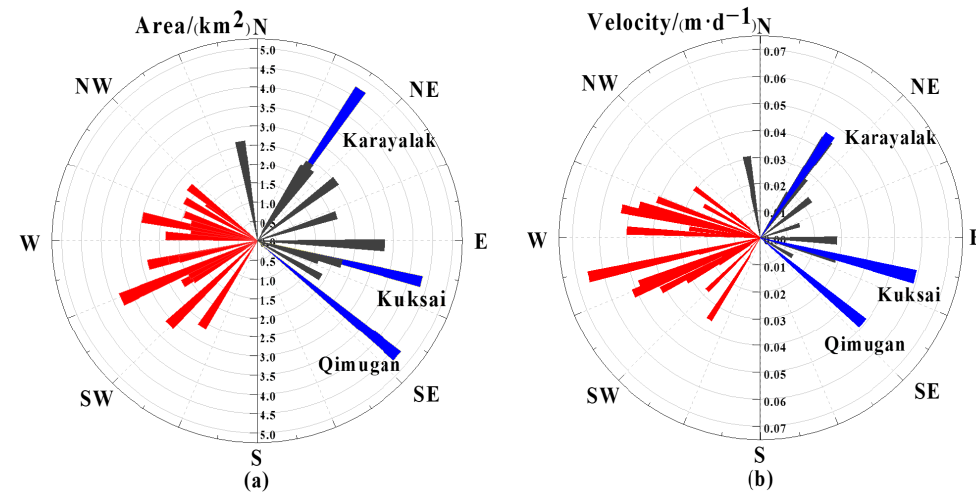
Figure 11. Glacier area and velocity in different slope directions: ( a ) area; ( b ) velocity. The red stripes represent glaciers on the western slope. The gray bands represent glaciers on the other slopes. The blue bands are the three largest glaciers in the Muztag-Kongur Mountains.